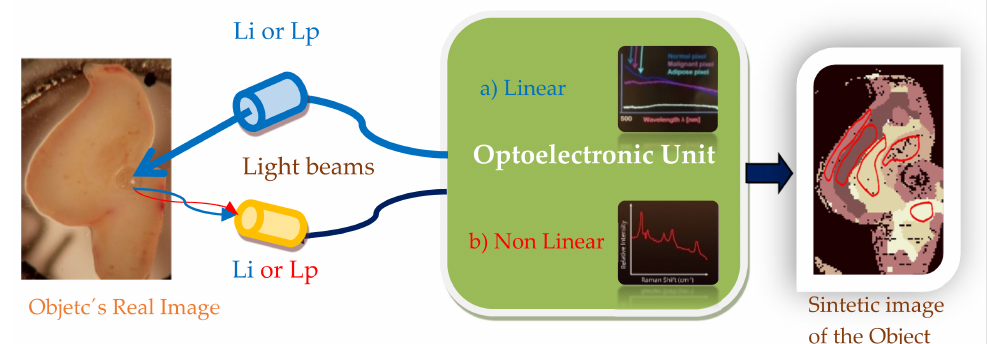
Figure 16. Illustration of a Smart Photonic Sensor able to perform, in quasi-real-time, the automatic discrimination of normal and tumor areas on the tissue of a human organ. The object is illuminated with a source of Light and after the interaction with the object: ( a ) By using linear scattering, a few accounts of Light’s photons (LM) of the same frequency return to the OU; the optical spectra are then obtained (inside the wavelength range of interest) and depending on the state of the tissue of the object, different spectra signatures are obtained for normal, diseased, and other types of tissues (if required); then, using the appropriate algorithms, each pixel is classified according to the type of tissue-state. In a basis of pixel per-pixel basis, a representative synthetic image of the state of the tissue is then reconstructed. ( b ) By using non-linear scattering, a very few accounts of Light’s photons (LM) of different frequency return to the OU in which their corresponding spectra are detected and correlated with the pixel state of the tissue; and (if required) a synthetic image (including the corresponding tissue type borders) can be reconstructed (and, if required, over-imposed on the real object’s image of the field of view of the surgeon). Made by the author based on material courtesy of the Photonic Engineering Group of